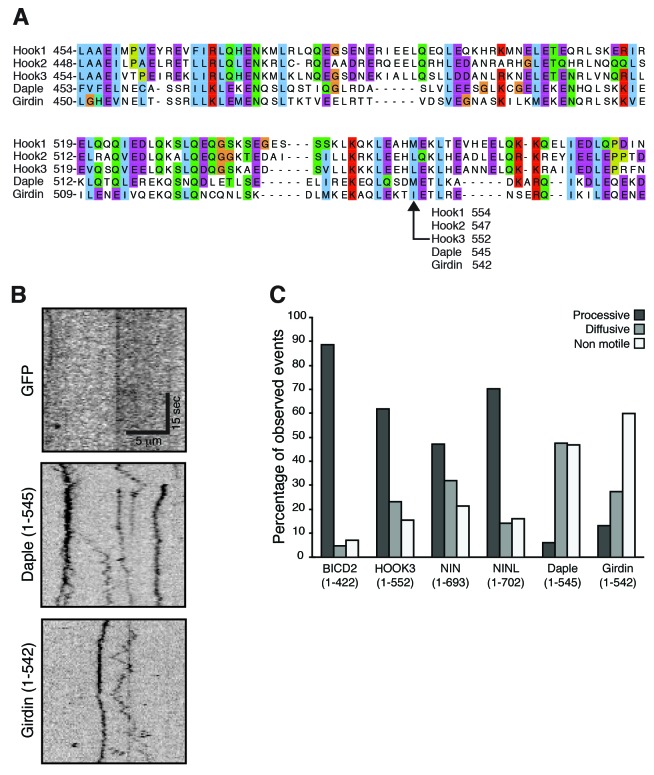
(A) The amino acid sequences for HOOK1, HOOK2, HOOK3 and two HOOK-related proteins (daple and girdin) were downloaded from Uniprot and aligned using Clustal Omega.A region containing the HOOK3 (1–552) C-terminal truncation point is displayed and the residue in each protein equivalent to HOOK3 (1–552) is indicated. (B) As a control for the experiments in Figure 4E—H, GFP-3×FLAG was immunoprecipitated with an α-FLAG antibody from HEK-293 cells. No moving GFP signal was detected on microtubules. (C) The percentage of processive, diffusive and non-motile runs (see Materials and methods) in single-molecule motility assays (as described in Figure 4E–H) was analyzed for NIN (1-693), NINL (1-702), girdin (1-542) and daple (1-545) and compared to the known activators BICD2 (1–422) and HOOK3 (1–552).